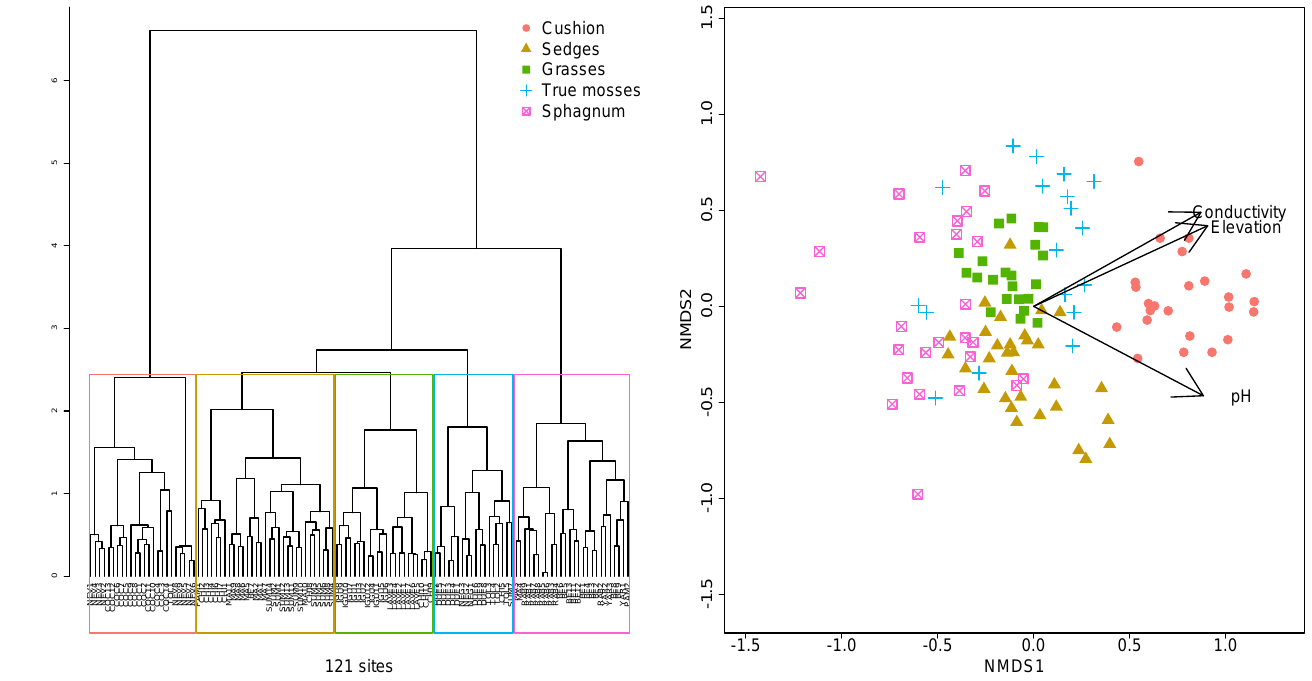
Figure 2. ( Left ) Hierarchical cluster using Ward’s distances on 121 peatlands in the northern Andes indicating the selection of 5 different plant composition groups. ( Right ) NMDS ordination of 121 peatlands in the northern tropical Andes with matching color codes to the 5 cluster groups. Fitted environmental variables in figure had a significant correlation with NMDS ordination after 999 permutations ( p < 0.01).